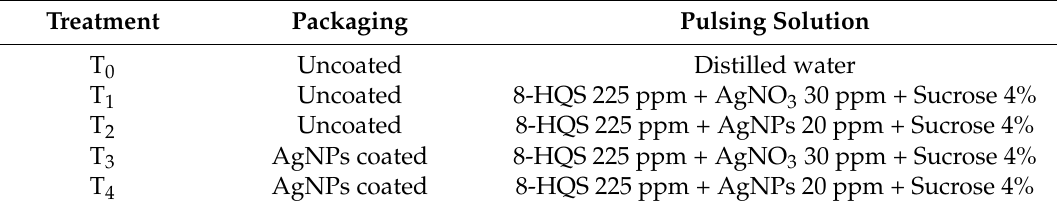
Table 1. The treatments used during the packaging